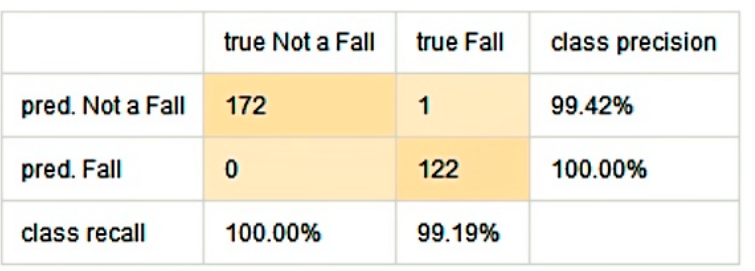
Figure 8. Confusion matrix representing the overall performance accuracy as well as the subclass precision values for the different activities, including falls, of the RapidMiner process shown in Figure 5 when the second dataset [51] was used.